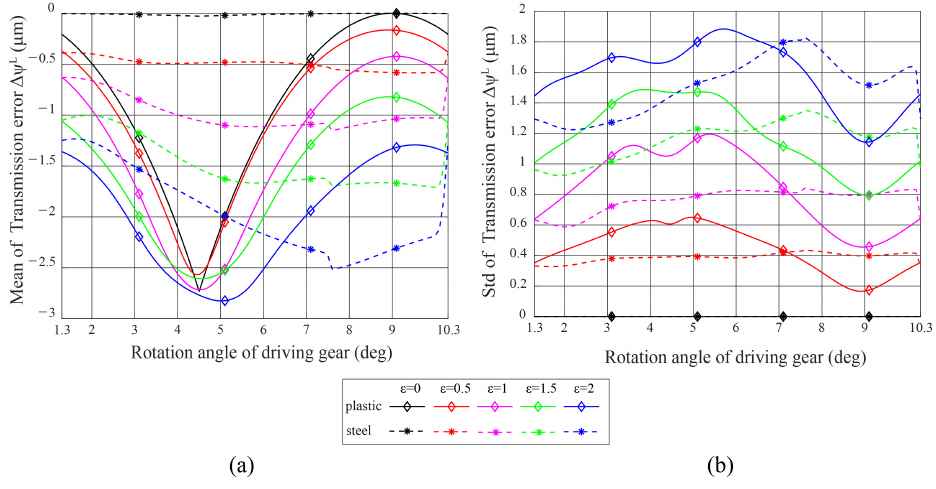
Figure 11. ( a ) Mean and ( b ) standard deviation (std) of transmission error under loaded condition. When the machining error ( (cid:101) ) increases, there is no thermal deformation or pitch error ( η = 0, e p = 0 ) .